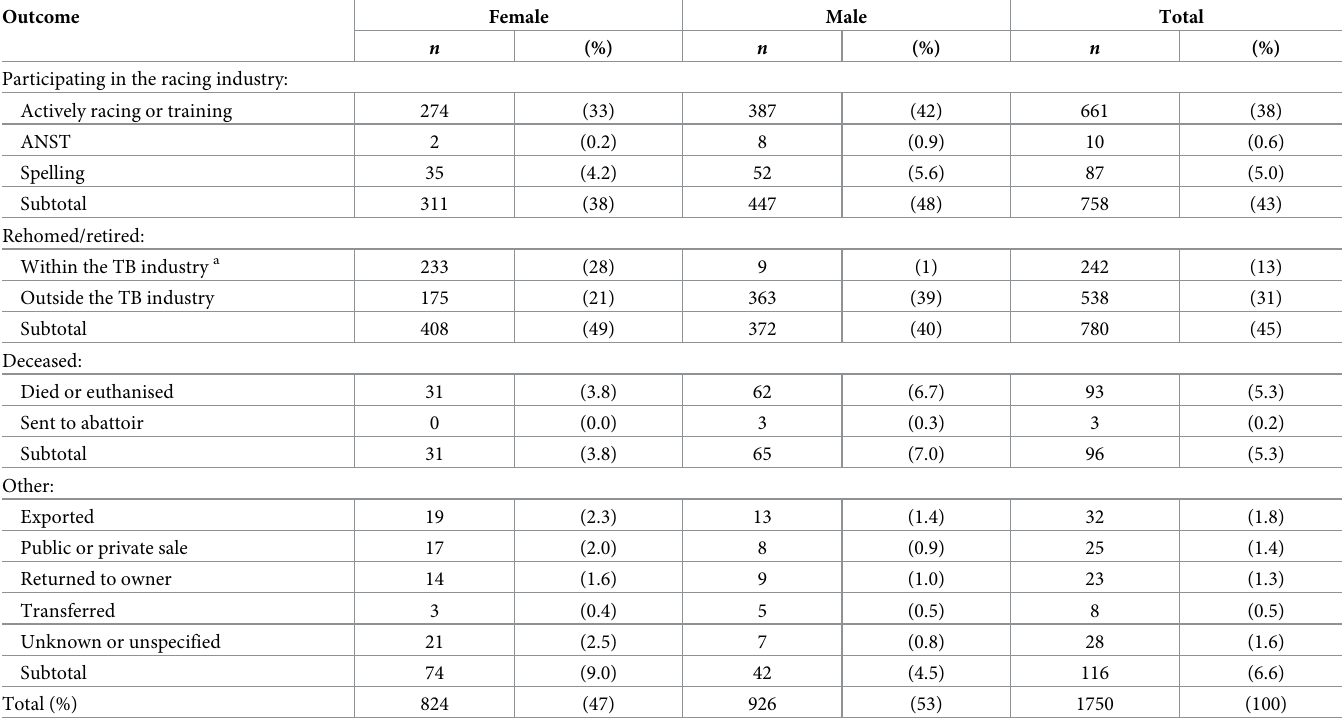
a Includes horses that retired as Australian Stud Book breeding stock ( n = 234) and horses retired within the industry as clerk of the course horses or lead ponies ( n = 8). ANST = Active Non-Stable Training; TB = Thoroughbred.